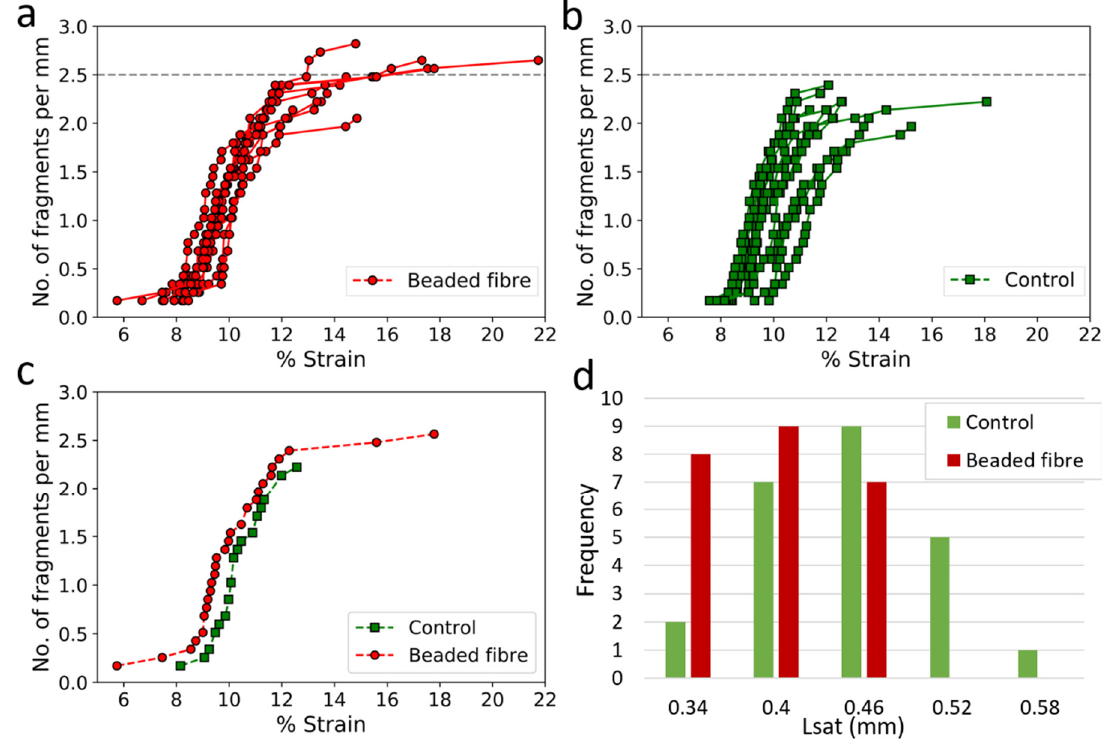
Figure 7. Fragments density vs. % strain for ( a ) Beaded fibres. ( b ) Bead-less fibres. ( c ) A comparison between typical behaviour of beaded fibre to bead-less fibre. The connecting lines are to identify each test separately. The error in strain is negligible. ( d ) Distribution of the fragment saturation length L sat for beaded fibres compared to the control.